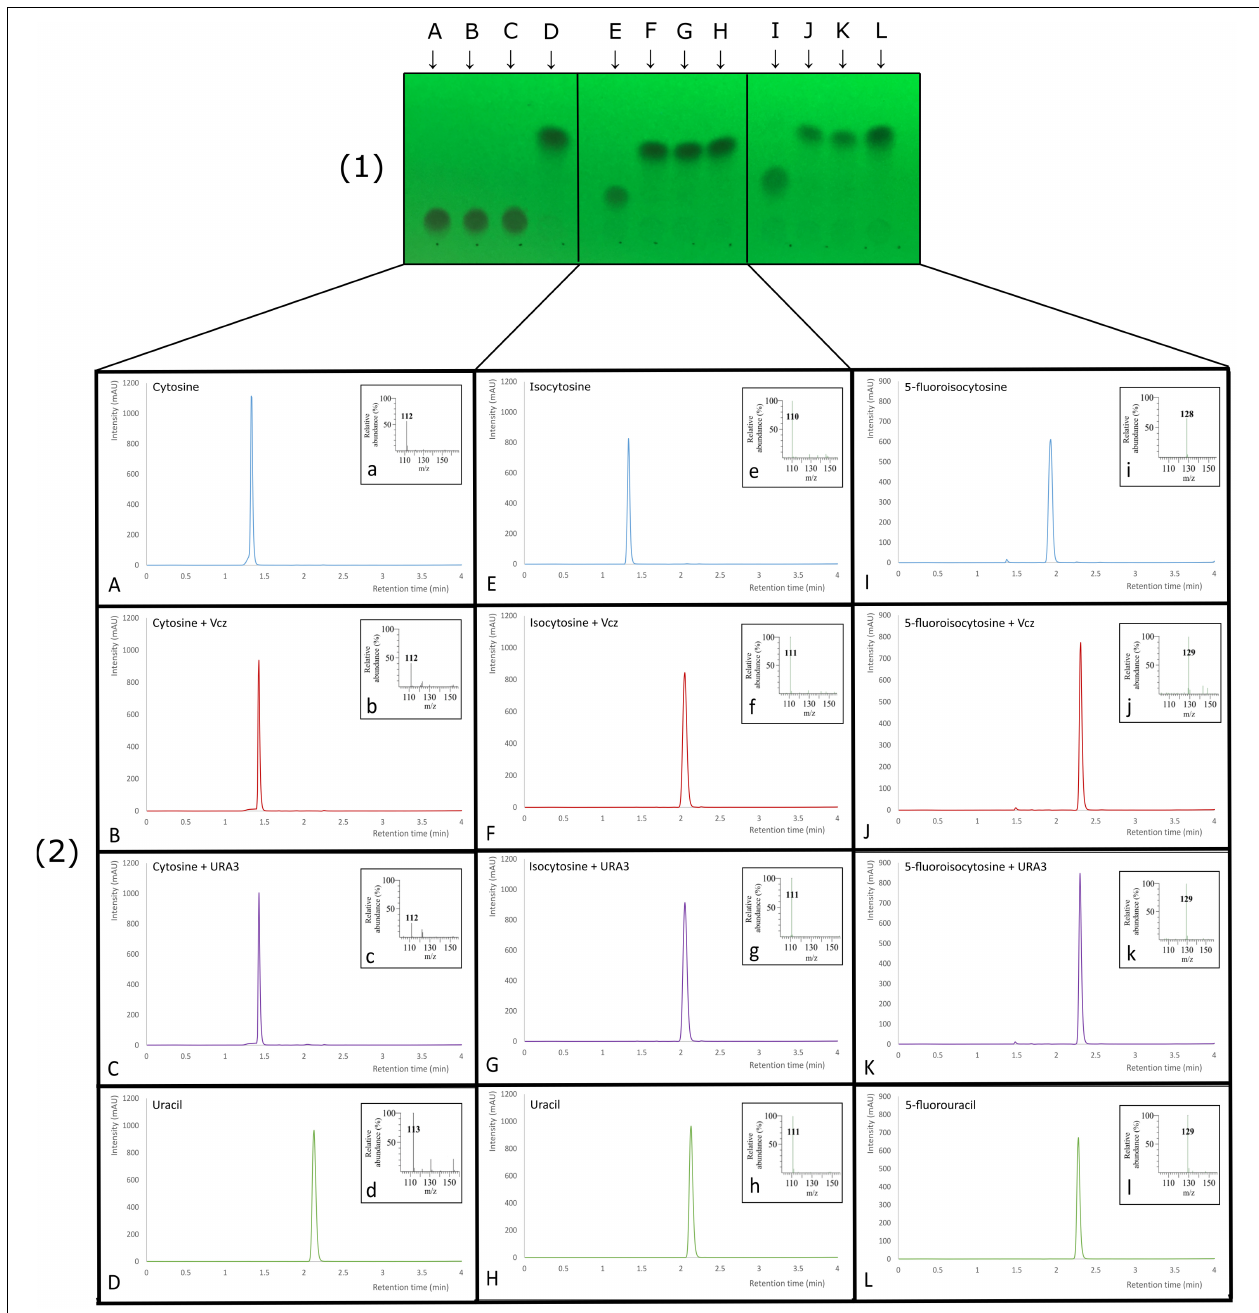
FIGURE 6 | Thin layer chromatography plate (1) and corresponding LC-MS analyses (2) of substrates (A,E,I) , enzymatic isocytosine deaminase Vcz (B,F,J) and URA3 (C,G,K) reactions and products (D,H,L) . (A) TLC and UV chromatogram of cytosine standard, (a) MS-spectra ( m/z of 112 consistent with [M + H] + of cytosine), (B) TLC and UV chromatogram of the reaction mixture using cytosine and Vcz deaminase, (b) MS-spectra ( m/z of 112 consistent with [M + H] + of cytosine), (C) TLC and UV chromatogram of the reaction mixture using cytosine and URA3 deaminase, (c) MS-spectra ( m/z of 112 consistent with [M + H] + of cytosine), (D) TLC and UV chromatogram of uracil standard, (d) MS-spectra ( m/z of 113 consistent with [M + H] + of uracil), (E) TLC and UV chromatogram of isocytosine standard, (e) MS-spectra ( m/z of 110 consistent with [M-H] − of isocytosine), (F) TLC and UV chromatogram of the reaction mixture using isocytosine and Vcz deaminase, (f) MS-spectra ( m/z of 111 consistent with [M-H] − of uracil), (G) TLC and UV chromatogram of the reaction mixture using isocytosine and URA3 deaminase, (g) MS-spectra ( m/z of 111 consistent with [M-H] − of uracil), (H) TLC and UV chromatogram of uracil standard, (h) MS-spectra ( m/z of 111 consistent with [M-H] − of uracil), (I) TLC and UV chromatogram of 5-fluoroisocytosine standard, (i) MS-spectra ( m/z of 128 consistent with [M-H] − of 5-fluoroisocytosine), (J) TLC and UV chromatogram of the reaction mixture using 5-fluoroisocytosine and Vcz deaminase, (j) MS-spectra ( m/z of 129 consistent with [M-H] − of 5- fluorouracil), (K) TLC and UV chromatogram of the reaction mixture using 5-fluoroisocytosine and URA3 deaminase, (k) MS-spectra ( m/z of 129 consistent with [M-H] − of 5- fluorouracil), (L) TLC and UV chromatogram of 5-fluorouracil standard, (l) MS-spectra ( m/z of 129 consistent with [M-H] − of 5- fluorouracil).